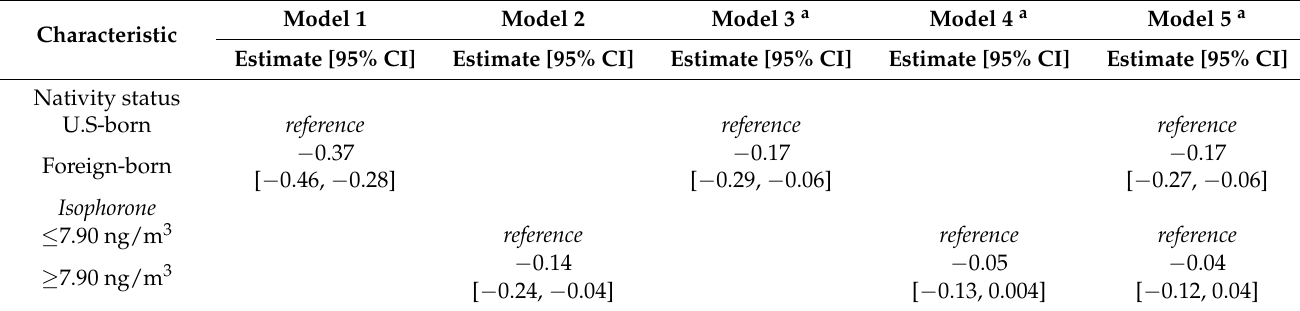
Table 2. Crude and adjusted effect estimates and 95% confidence intervals estimating the effect of maternal nativity status and isophorone exposure on mental z-scores in the ECLS-B population (2001 birth cohort).